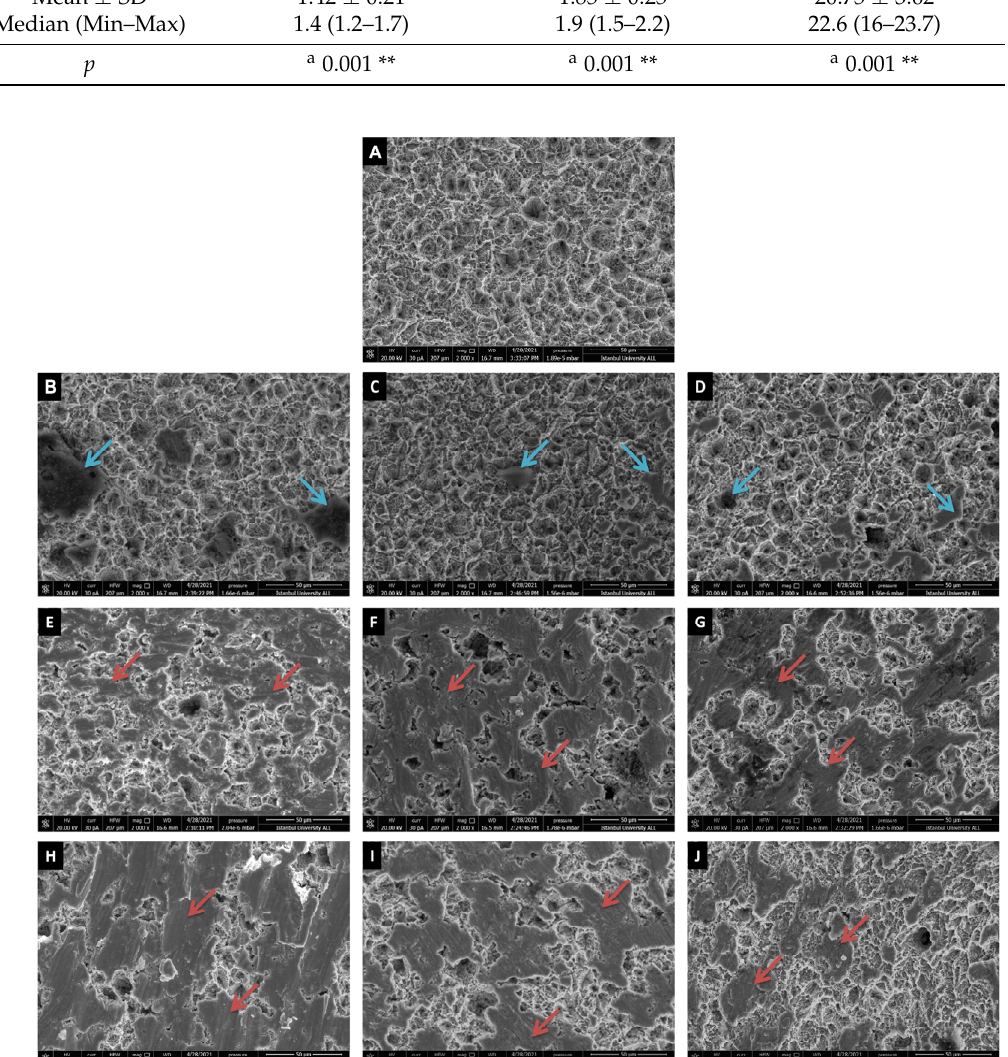
Figure 1. SEM images of SLA Ti discs. ( A ) Control group, ( B ) Laser, blue arrows point to melting areas, ( C ) Laser + H 2 O 2 , ( D ) Laser + CHX, ( E ) Ti-brush, red arrows point to smooth-flattening areas, ( F ) Ti-brush + H 2 O 2 , ( G ) Ti-brush + CHX, ( H ) Ti-curette, ( I ) Ti-curette + H 2 O 2 and ( J ) Ti-curette + CHX. Images of each group demonstrate 2000x magnification.